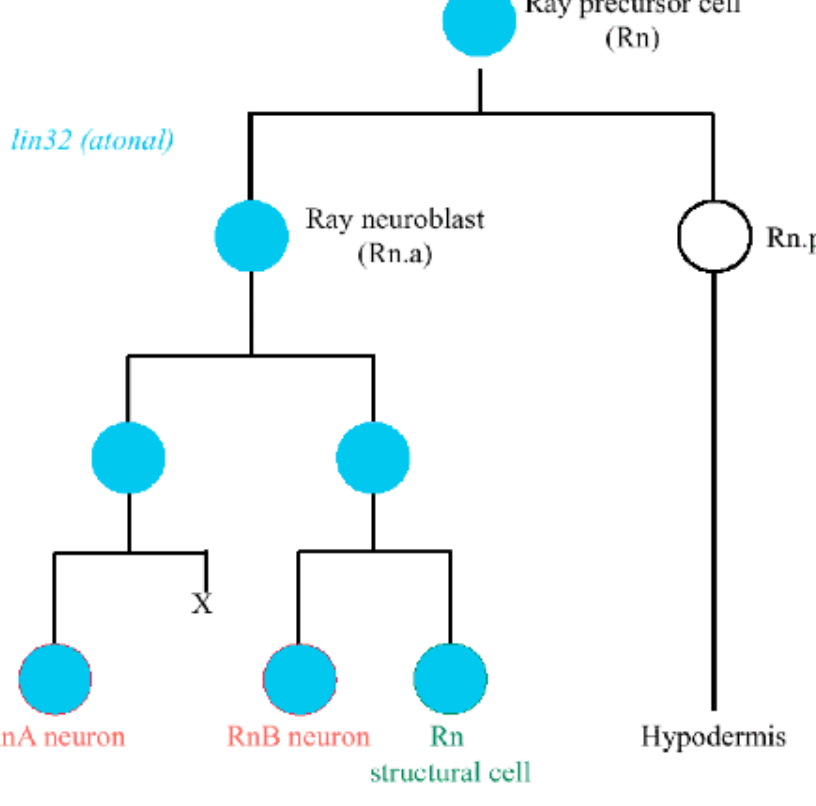
FIGURE 8. The ray sublineage in C. elegans . The ray precursor cell (Rn) divides and gives rise to an anterior daughter (Rn.a), the ray neuroblast, and a posterior daughter (Rn.p) which gives rise to hypodermis. Rn.a divides twice to generate the two ray neurons (RnA and RnB), the ray structural cell (an accessory cell), and a cell that undergoes programmed cell death (X). The atonal ortholog, lin-32, is expressed in the whole lineage, from Rn to the differentiating daughter cells, except in the non-neural Rn.p cell. No other bHLH is expressed in this